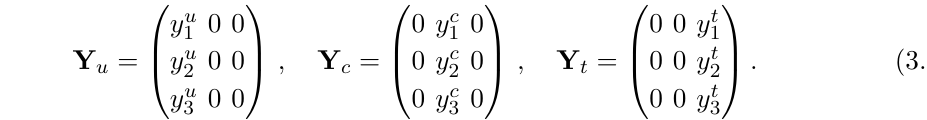
= v Y + v Y + v Y , up u c t t d b